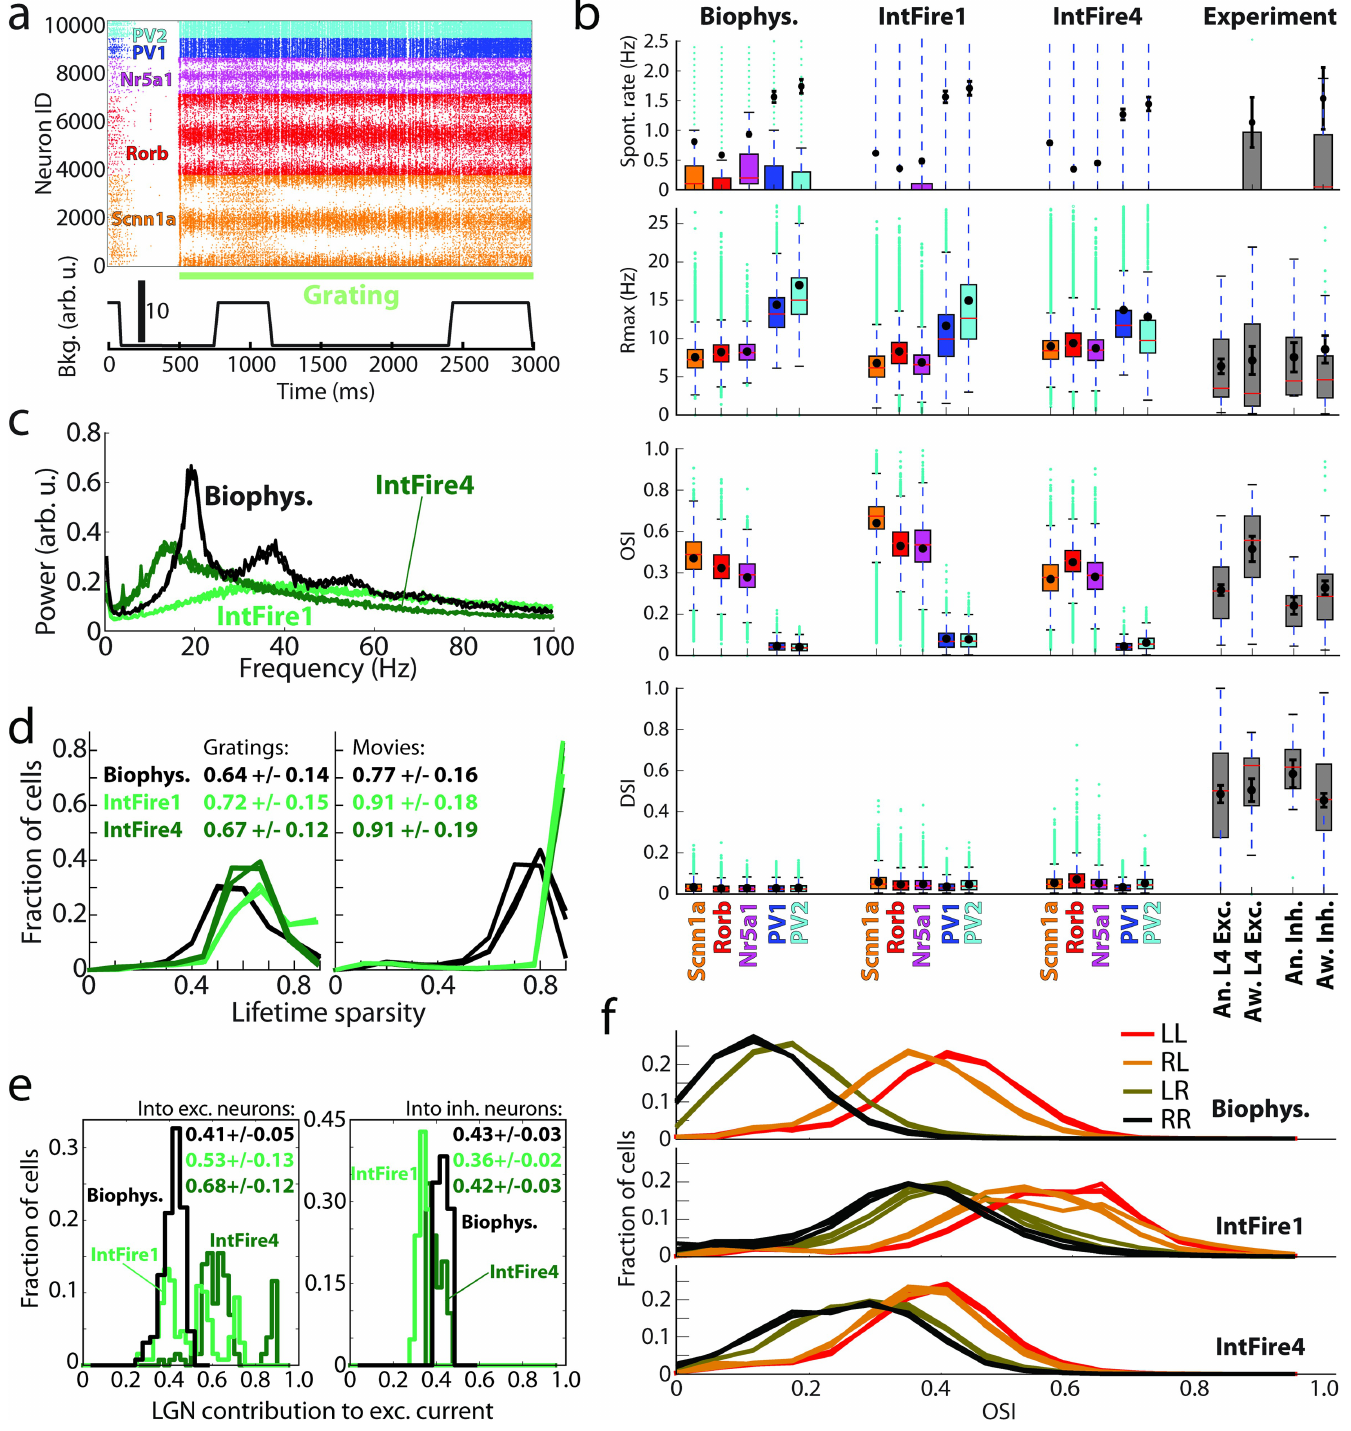
Fig 6. Comparison of biophysical and all-LIF simulations employing the IntFire1 or IntFire4 models. (a) An example spike raster in response to a drifting grating in , OSI and DSI by cell type. (c) Spectra of multi-unit activity (weighted by 1/r , where r is the distance from the an all-LIF IntFire1 simulation. (b) Spontaneous rate, R max cell to the center of the system). This is used as a proxy to LFP, which cannot be directly computed for the point-neuron models. Note that exact match between this metric and the actual LFP computed for biophysical model (see Fig 3C ) is not expected, but they both exhibit similar features, such as a prominent peak at ~20 Hz. (d) Distributions of lifetime sparsity of responses to gratings and movies, averaged over 10 trials. The data are for three directions of a grating (0, 45, and 90 degrees) and for three movies. (e) Distributions of LGN contribution to the total excitatory synaptic inputs across excitatory and inhibitory cells (in the IntFire1 and IntFire4 cases, this is